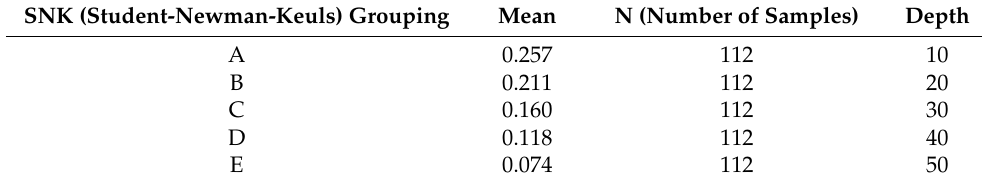
Table 3. Difference analysis at different depths.